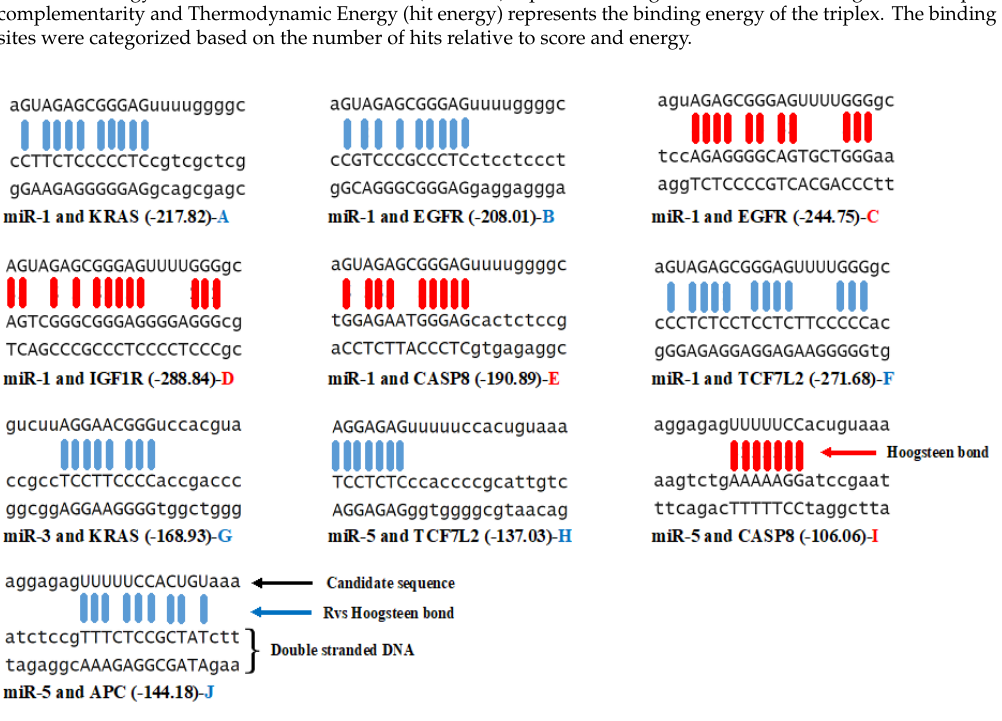
structure ( A – J ) represent the candidate microRNA sequences involved in triplex binding while the two